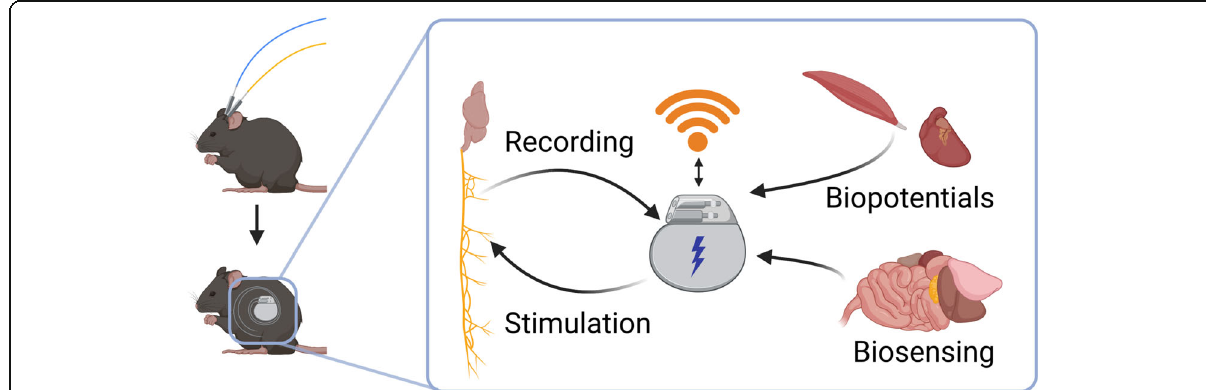
Fig. 1 Transition from tethered approach to a fully implantable approach. The implantable device provides stimulation and sensing capability. Data telemetry and control signals are communicated using a wireless